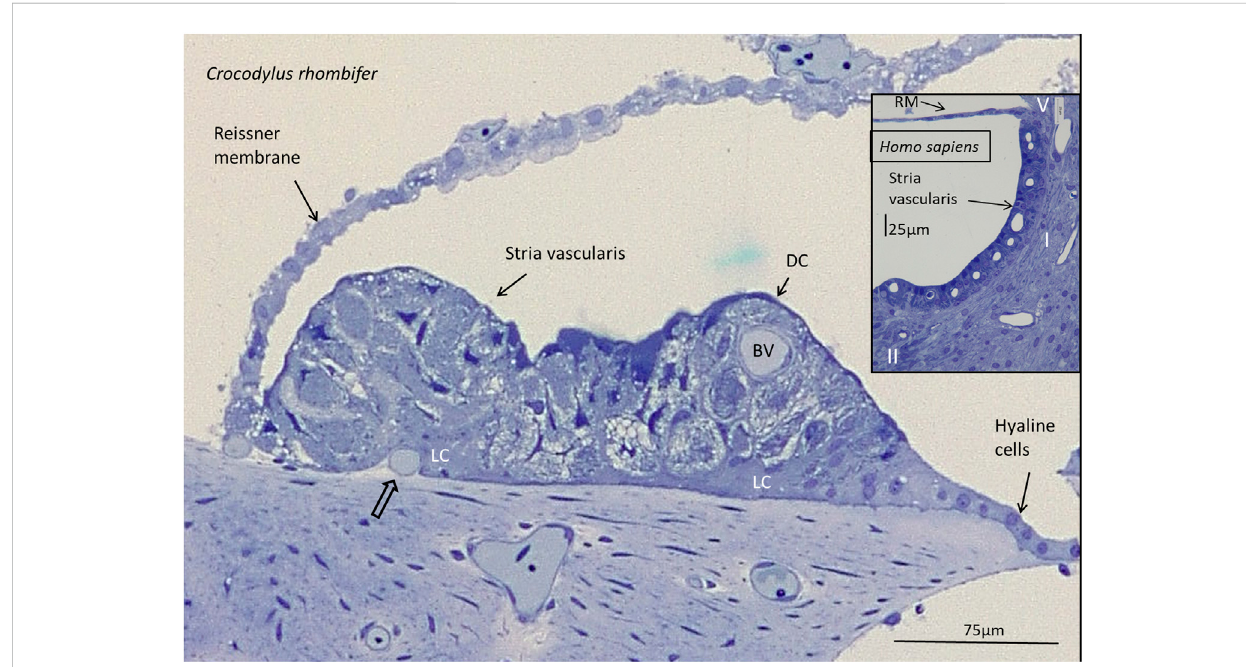
FIGURE 2 Light microscopy of the stria vascularis in the Crocodylus rhombifer at the lateral fi brocartilaginous plate. There is a multi-layered epithelium with apical dark cells (DC) and basally light cells (LC). The epithelium contains blood vessels (BV). A vessel is seen to merge with the epithelium (open arrow). Inset shows the SV in the basal turn of a human cochlea for comparison. It contains marginal, intermediate and basal cells. Together with the lateral fi brocytes,theyarebelievedto secreteandrecirculateK + ionsandgeneratean endocochlear (EP)essential forsensory haircelltransduction.TypeI, II, and V fi brocytes are shown of the fi ve different types (I – V). RM, Reissner membrane.